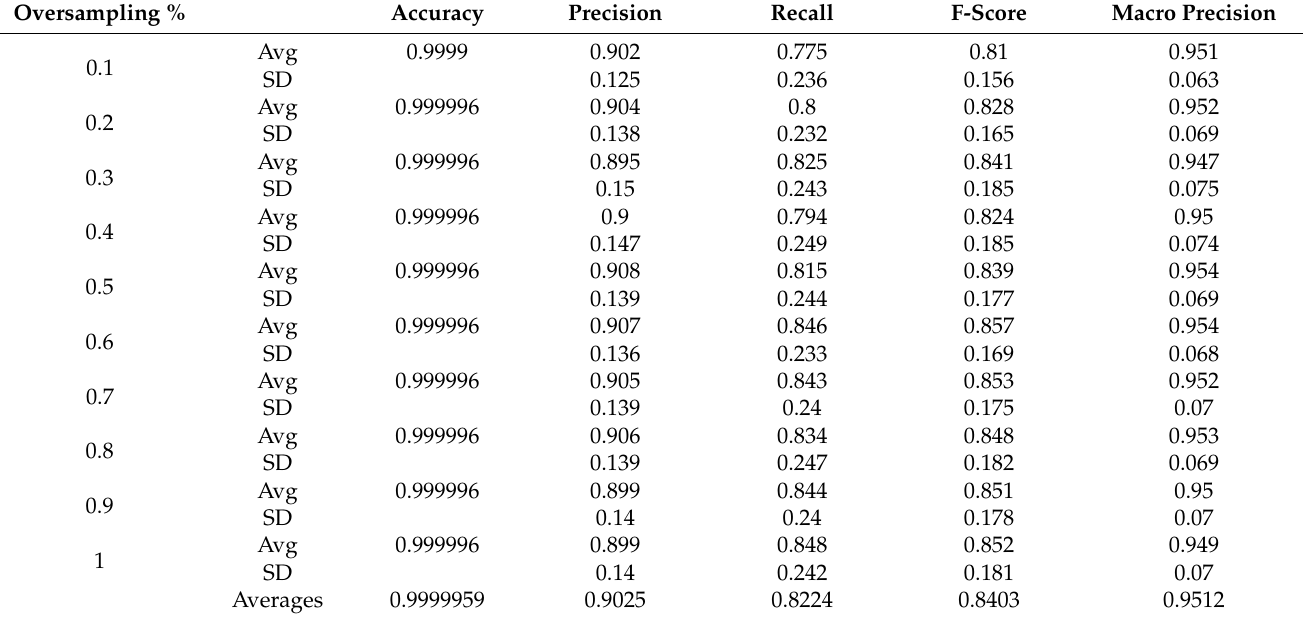
Table 13. UWF-ZeekData22: privilege escalation—classification results for random undersampling before splitting.